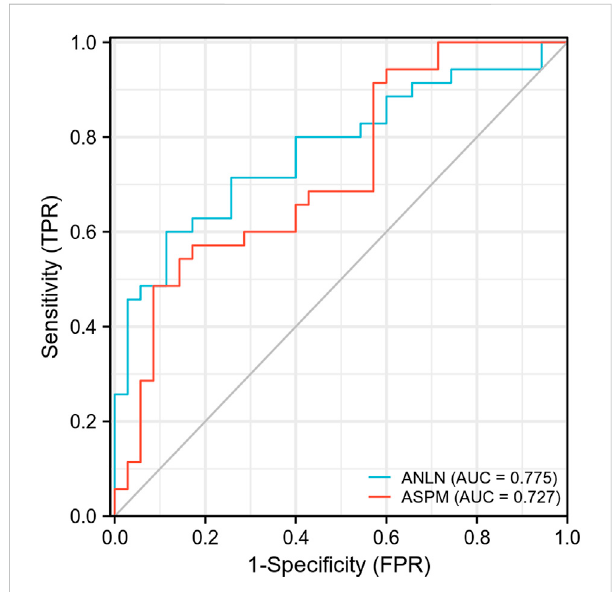
FIGURE 6 ROC curve for the expression levels of both ANLN and ASPM genes in bladder cancer tissues versus paracancerous tissues. ROC, receiver operating characteristics; AUC, area under the